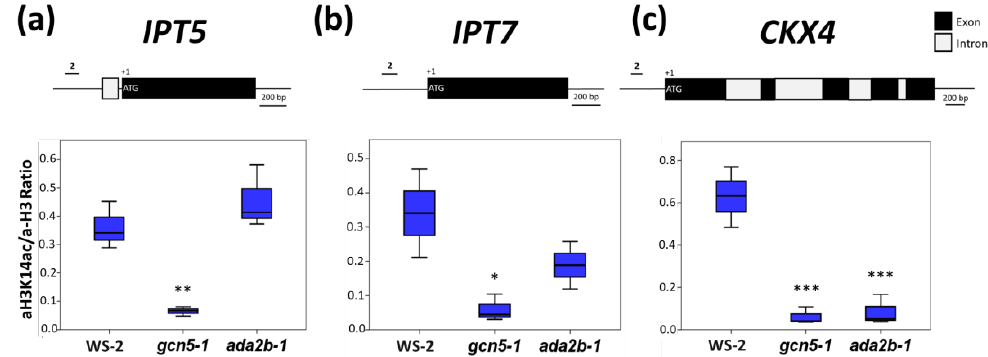
Figure 5. Histone acetylation of H3K14 in roots of seven-day-old Ws-2, gcn5-1 , and ada2b-1 plants. The promoter region was analyzed for each genomic region as indicated by the line above the gene model. ( a ) The IPT5 , ( b ) IPT7 , and ( c ) CKX4 proximal promoter regions were analyzed. The immunoprecipitated DNA fragments were analyzed by qRT-PCR, and the values were obtained as a percentage of input. Antibodies against Histone H3 and acetylated Histone H3K14 were used. The ratio of H3K14ac to H3 is presented. The bars represent the range of the two quadrants, the horizontal line in the bar the median, while the terminals are the minimum and maximum values of the data. Asterisks indicate the statistical significance of three technical repeats of two mutants compared to wild type based on an independent samples T-test: * p < 0.05, ** p < 0.01, and *** p < 0.001.